Question: Describe this figure in one sentence.
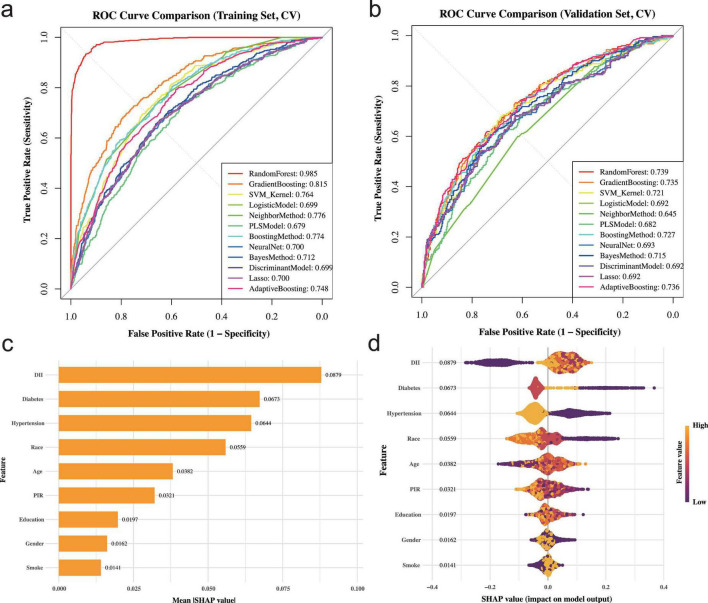
Answer: Machine learning performance and SHAP-based interpretability of predictors for NAFLD. (a) ROC curves comparing the performance of different machine learning models in the training set using cross-validation. (b) ROC curves of the same models in the validation set. (c) Feature importance ranked by mean absolute SHAP values from the random forest model. (d) SHAP summary plot illustrating the direction and magnitude of each feature’s contribution to model output.